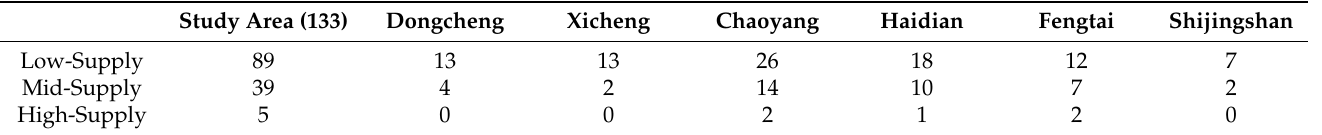
Figure 4. Spatial pattern of TPS ( left ); spatial pattern of UPGS ( right ). Table 7. Statistics of TPS.